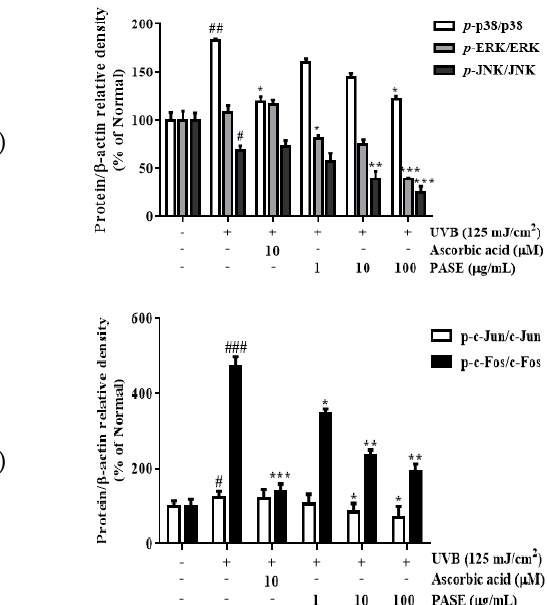
Figure 6. PASE inhibited the phosphorylation of MAPK/AP-1-signaling protein levels in UVB-exposed HaCaT cells: Phosphorylated and non-phosphorylated members of the MAPKs (ERK, JNK, and p38) ( a ) AP-1 complex (c-fos and c-jun) ( c ) protein levels; the band intensities ( b , d ). Data are shown as means ± SDs of three independent experiments. # p < 0.05, ## p < 0.01, ### p < 0.001 compared with non-exposed group, * p < 0.05, ** p < 0.01, *** p < 0.001 compared with only UVB-exposed group.